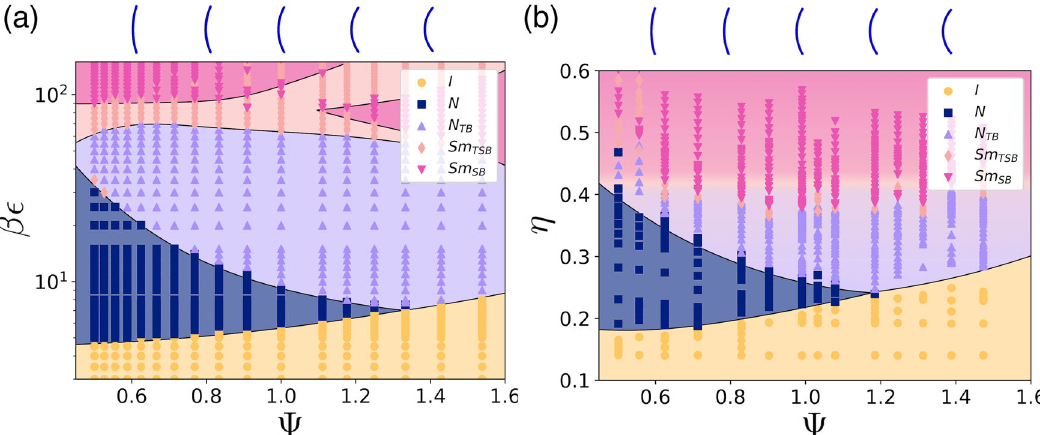
Fig. 3 Phase diagram of curved spherocylinders. Phase behaviour of hard curved spherocylinders as ( a ) predicted by theory, as a function of inverse temperature βϵ and particle curvature Ψ , and ( b ) obtained from simulations, as a function of packing fraction η and Ψ . Both phase diagrams exhibit an isotropic (I) phase at low βϵ and η , respectively. For small particle curvatures Ψ the I phase transitions into an uniaxial nematic (N) phase upon increasing βϵ or η . The stability range of the N phase decreases with Ψ and disappears at Ψ ≳ 1.2. Upon increasing βϵ or η further, the twist-bend nematic (N transforms into a twist-splay-bend smectic (Sm TSB ) phase, and eventually into a splay-bend smectic (Sm SB ) phase. The splay deformations in the nematic director fi eld are accompanied by density modulations. Source data are provided as a Source Data fi